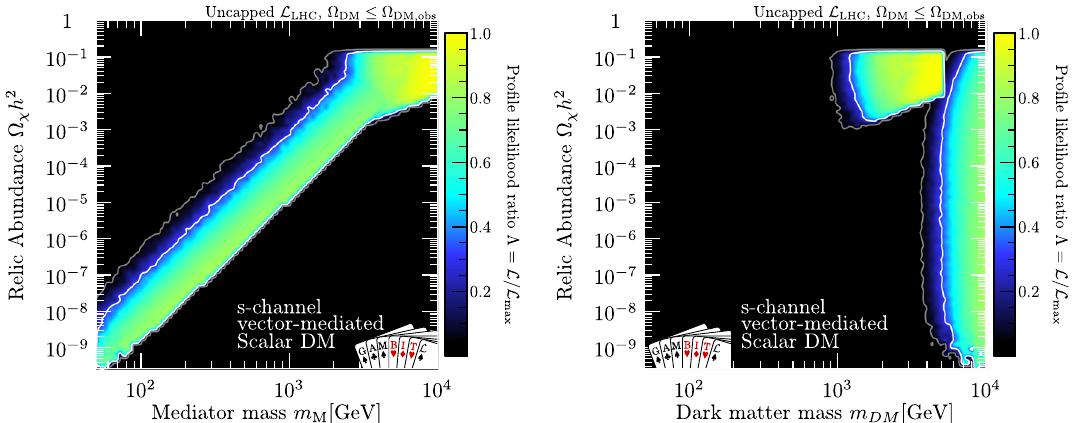
Fig. 3 Relic Density of the scalar DM model as a function of the mediator mass (left) and DM mass (right). The results are shown for the scan where the observed relic density of DM is allowed to exceed the abundance of the scalar DM candidate. 1 σ and 2 σ contours are shown in white and grey